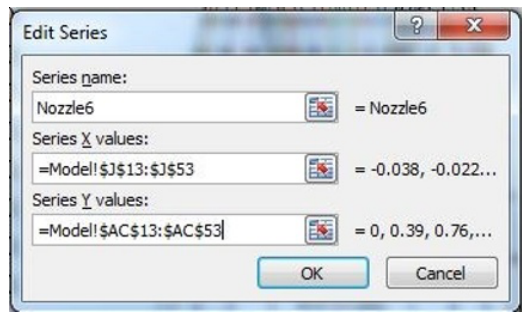
Fig. 9 . Dialogue window Edit Series This action causes the Edit Series dialog box. It fields are empty. The window that appears when you